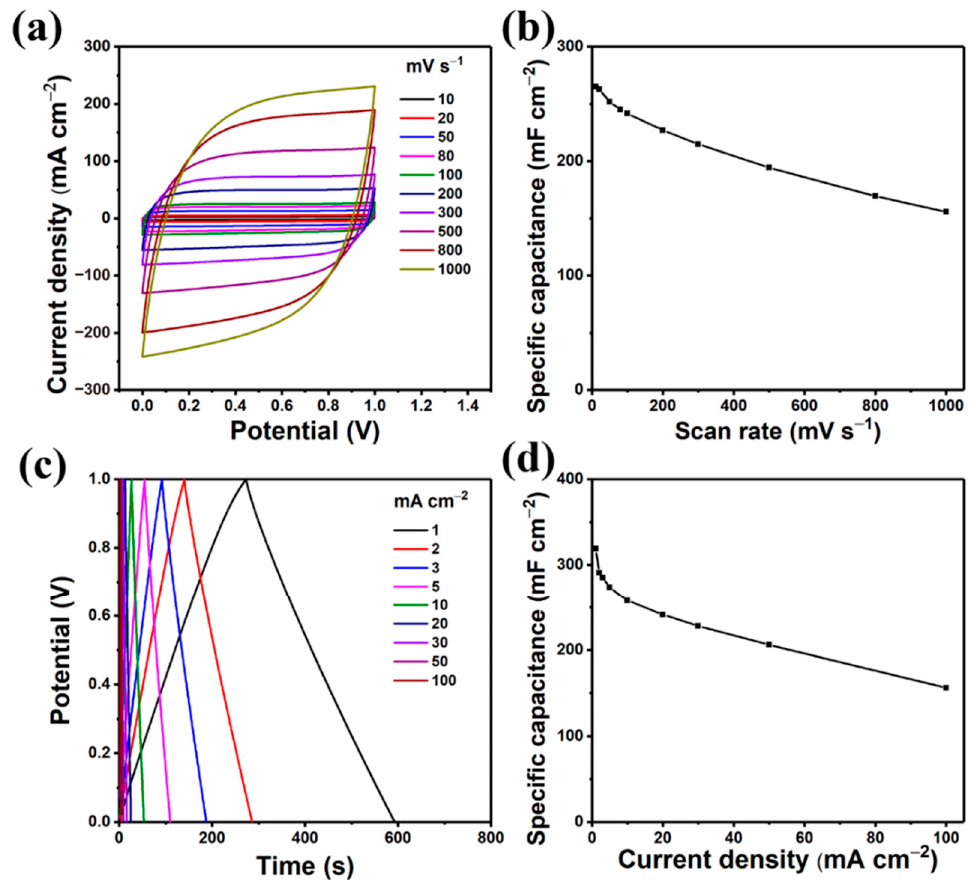
Figure 6. Electrochemical measurements of the CV and GCD curves of the two-electrode configuration: ( a ) CV curves with different scan rates; ( b ) calculated areal specific capacitance values at different scan rates; ( c ) GCD curves with different current densities; ( d ) calculated areal specific capacitance values at different current densities.